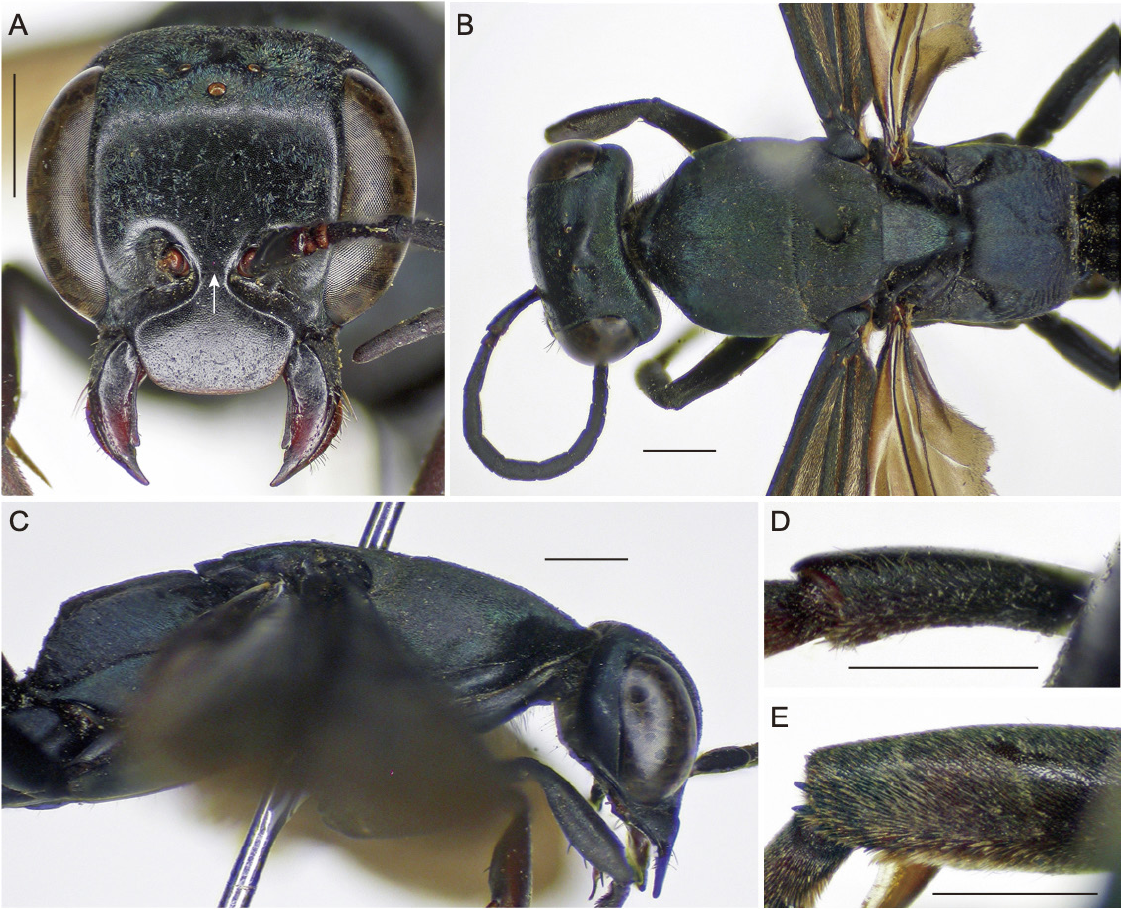
Fig. 10. Female of Psorthaspis planata (Fox, 1892) (#53) (UMUT). A . Head, anterior view, arrow indicates frontal bridge. B . Head and mesosoma, dorsal view. C . Head and mesosoma, lateral view. D . Left scape, dorsal view. E . Apical part of right fore tibia, mesial view. A number in parentheses after a species name is a specimen number in Supp. file 1. Scale bars: A–C = 1 mm; D–E = 0.5